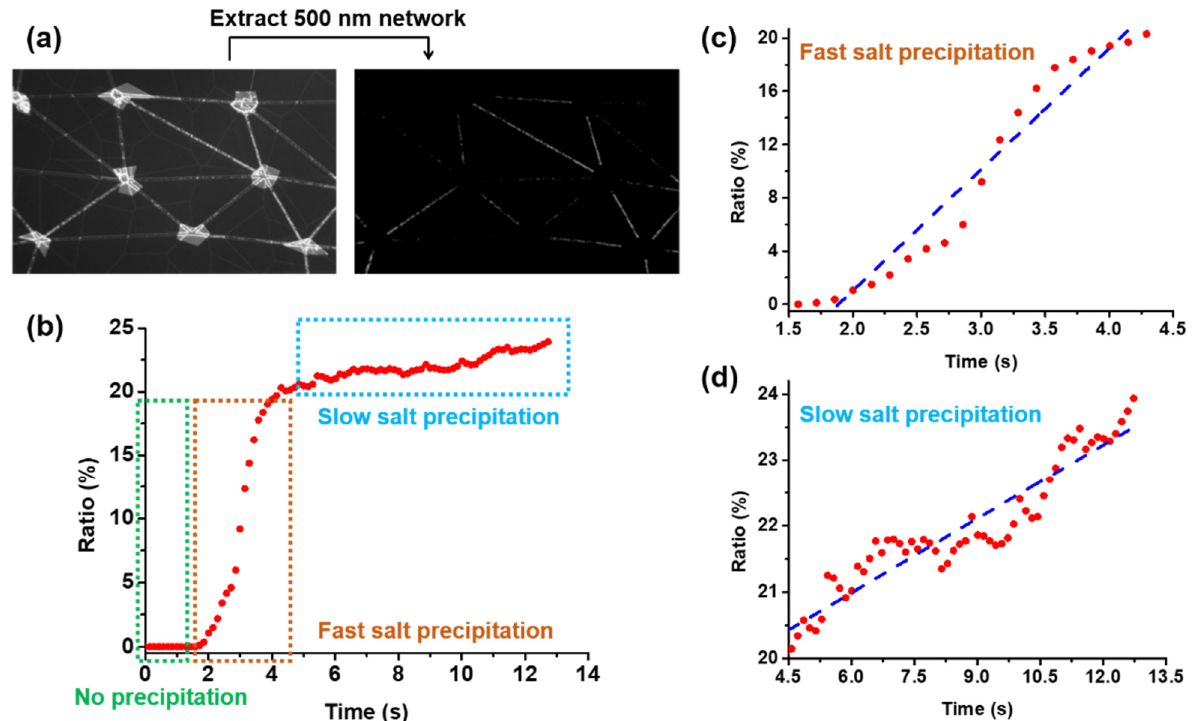
Figure 3. Salt precipitation dynamics in the 500-nm deep network. ( a ) Image analysis to extract precipitated salt particles in the 500-nm deep network. ( b ) the occupancy of the salt particles in the 500-nm deep network. The ratio is defined as the total volume of the precipitated salt divided by the total volume of the 500-nm deep network in the observation area. ( c ) Fast salt precipitation and its linear fitting result (slope = 9.1 ± 0.5, R 2 = 0.95). ( d ) Slow salt precipitation and its linear fitting result (slope = 0.37 ± 0.02, R 2 = 0.89).